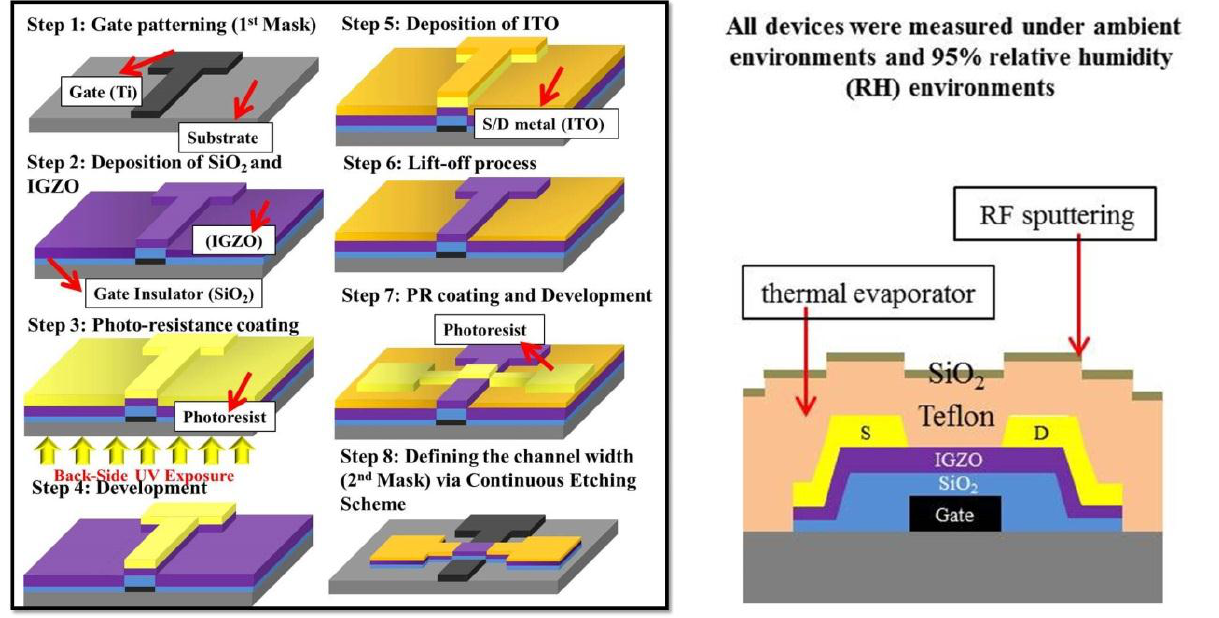
Figure 1. Two-photomask process flow of amorphous indium–gallium–zinc oxide (a-IGZO) thin-film transistors (TFTs) subjected to Teflon/SiO 2